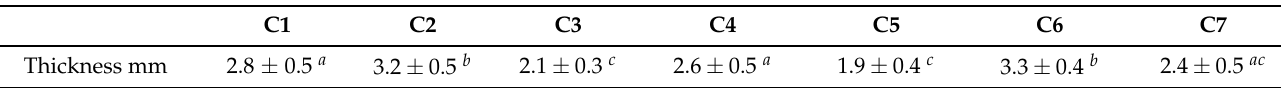
Table 3. Mean and standard deviations of the thickness of the fried nuggets’ coatings. Different letters ( a – c ) indicate significant differences ( p < 0.05) among the samples ( n = 20).